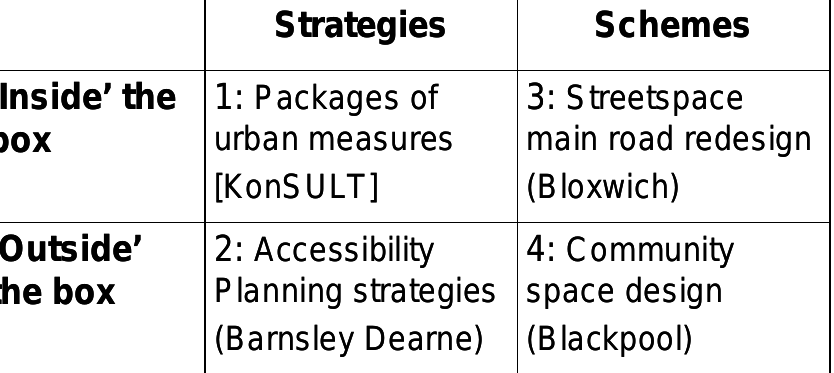
Figure 3. DISTILLATE option generation